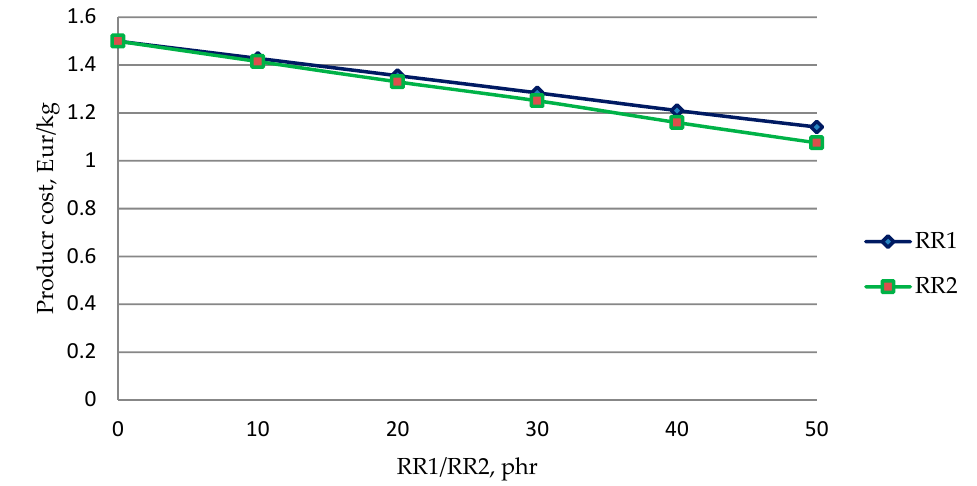
Figure 9. Reducing of products cost made in the case of use RR1 and RR2 regenerated rubber.